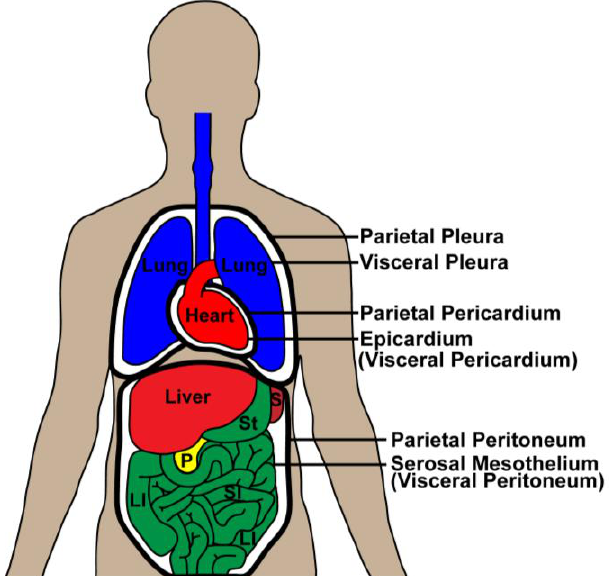
Figure 1. Mesothelia. Parietal mesothelia (thick black lines) cover the body wall and pericardial sac. Visceral mesothelia cover the organs and mesenteries and form a continuous lining with the parietal mesothelia. LI, large intestine; P, pancreas; S, spleen; SI, small intestine; St,